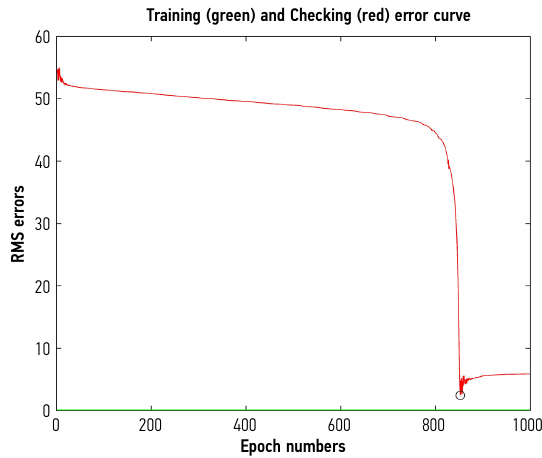
Training (green) and Checking (red) error curve